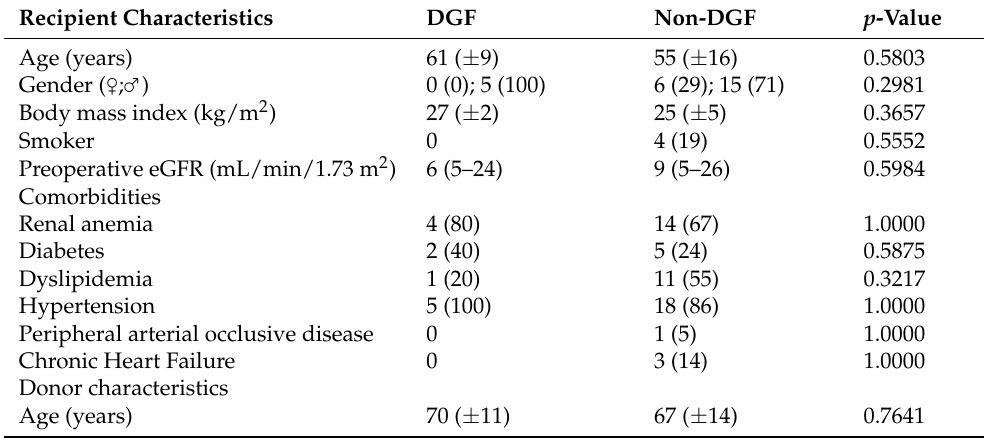
Table 2. Comparison of recipient, donor, and periprocedural characteristics between recipients with normal graft function (Non-DGF, n = 21) and those with delayed graft function (DGF, n = 5) after kidney transplantation. Continuous variables are expressed as mean and standard deviation. For categorical variables, absolute (numbers) and relative (percentages) frequencies are